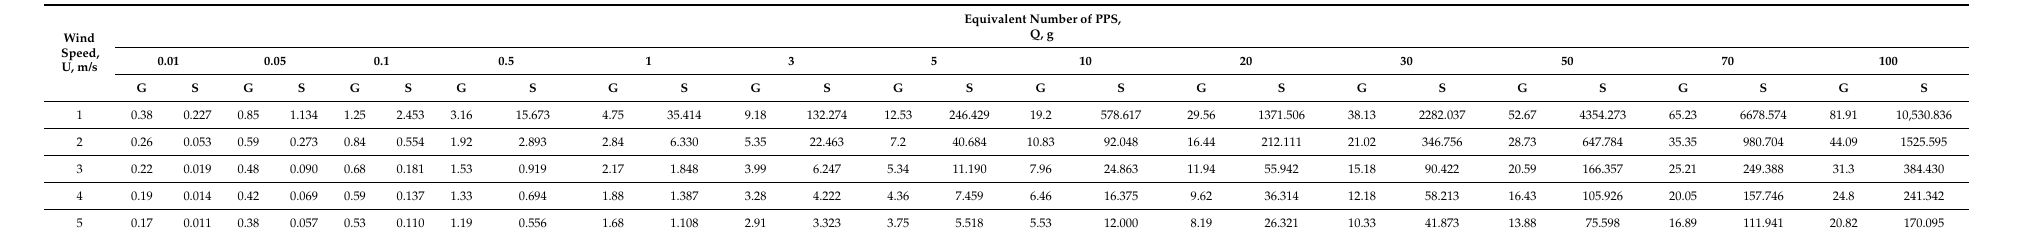
Table 1. Calculated results for PPS and wind